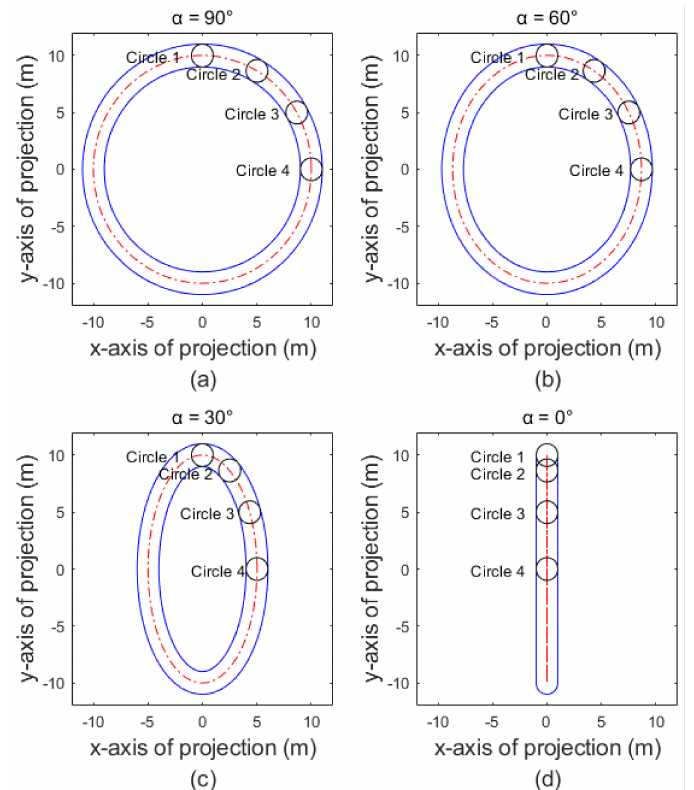
Figure 3. Projection of the single coil wire rope under four projection angles. ( a ) α = 90 ◦ ; ( b ) α = 60 ◦ ; ( c ) α = 30 ◦ ; ( d ) α = 0 ◦ . The four small circles in ( a – d ) correspond to the projection of a small sphere at the positions of 0 ◦ , 30 ◦ , 60 ◦ and 90 ◦ ,